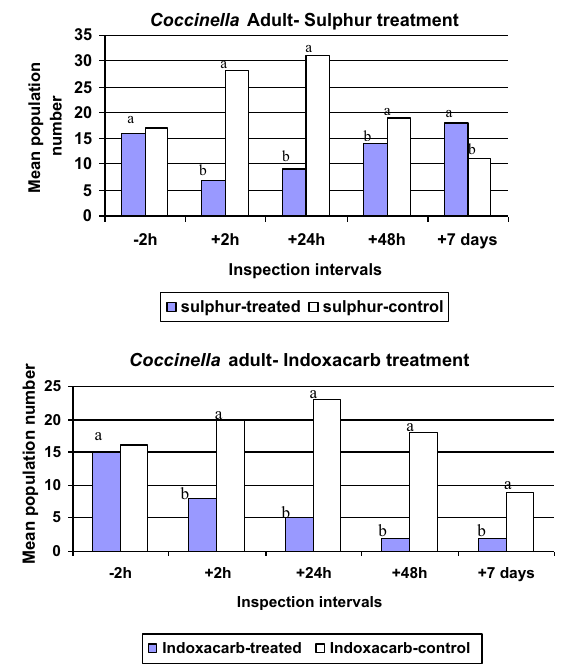
Fig. 2 Effect of indoxacarb and sorell 98% applications on the abundance of Coccinella adult. Significant differences were calculated separately for each